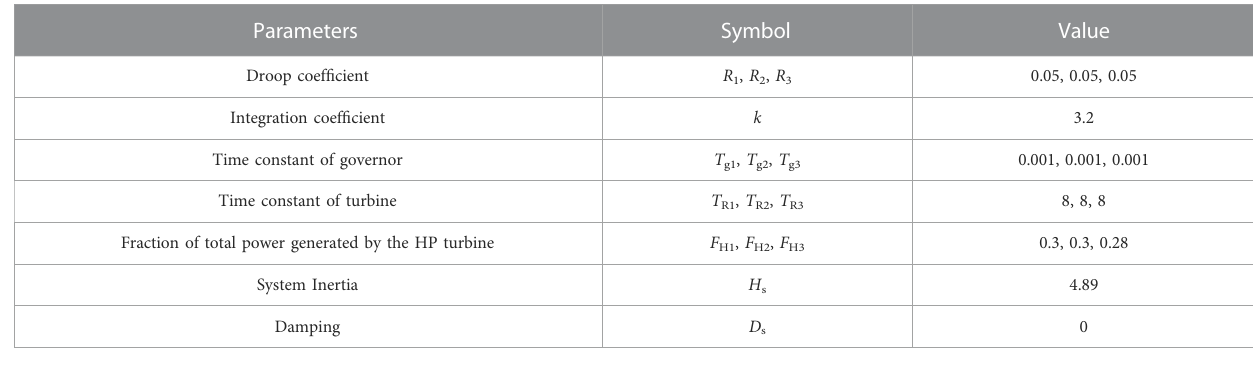
TABLE 1 Parameters of Power system.